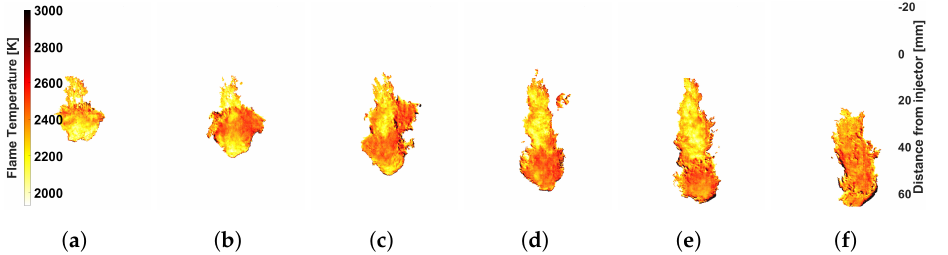
Figure 9. T maps obtained after processing. ( a ) 1500 µ s. ( b ) 1850 µ s. ( c ) 2200 µ s. ( d ) 2550 µ s. ( e ) 2900 µ s. ( f ) 3250 µ s.